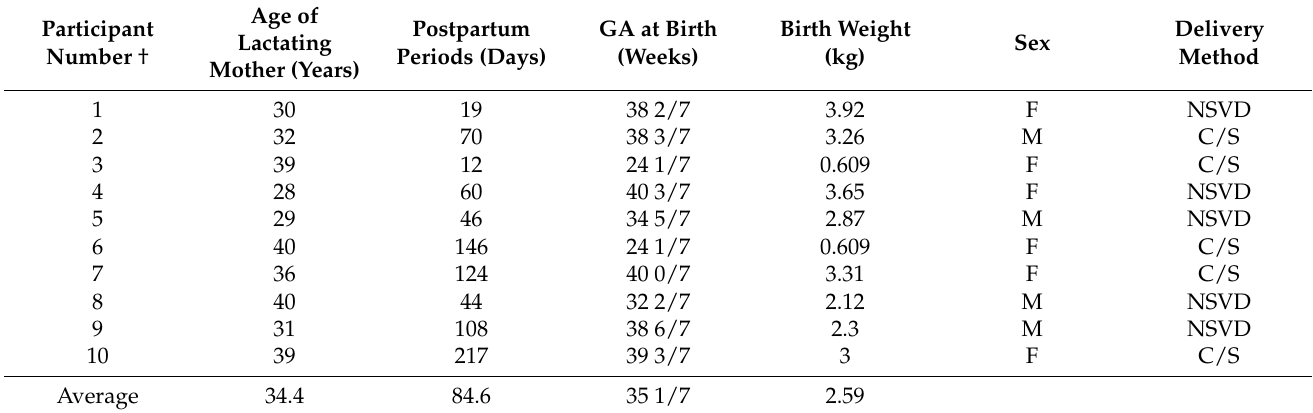
Table 1. Participant information for microRNA analysis of breast